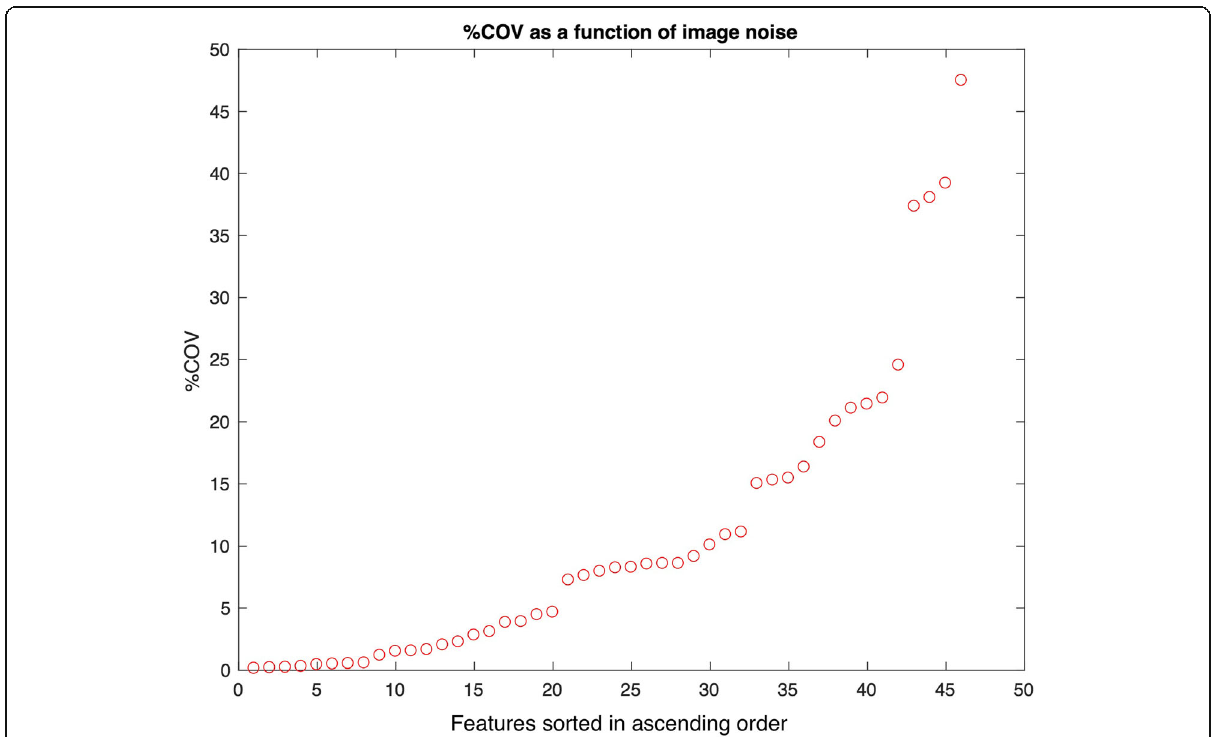
Fig. 3 Percentage coefficient of variation (%COV) as a function of noise for 46 features (14 statistics and 32 texture features), sorted in ascending order. Of 46 features, 4 demonstrated a low robustness (%COV >